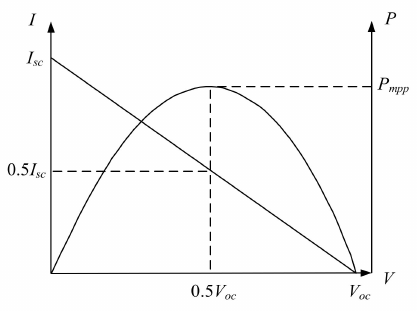
Figure 2. TEG P–I–V Curves.